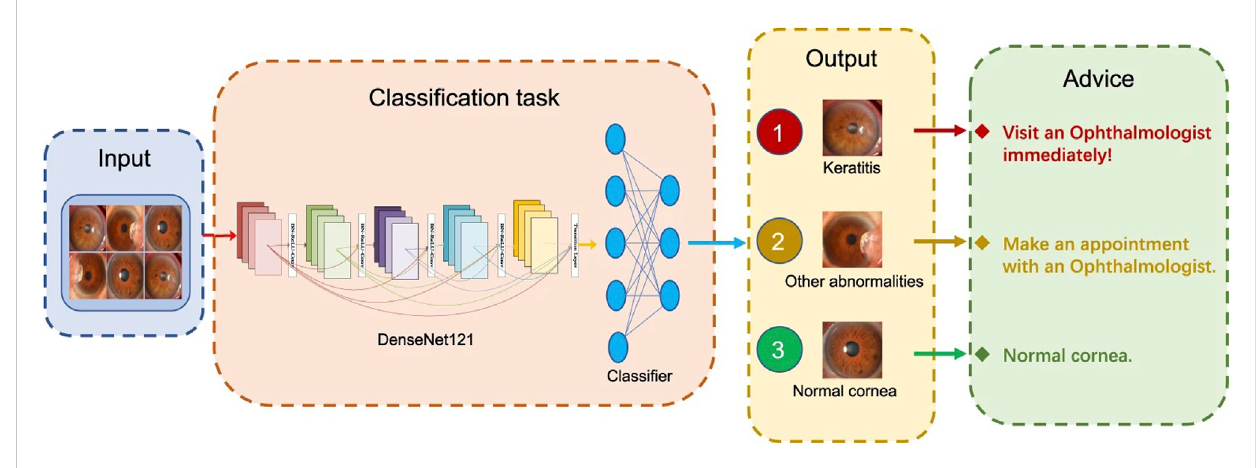
FIGURE 4 Work fl ow of the DL system in clinics for detecting abnormal cornea fi ndings (Li Z. et al.,